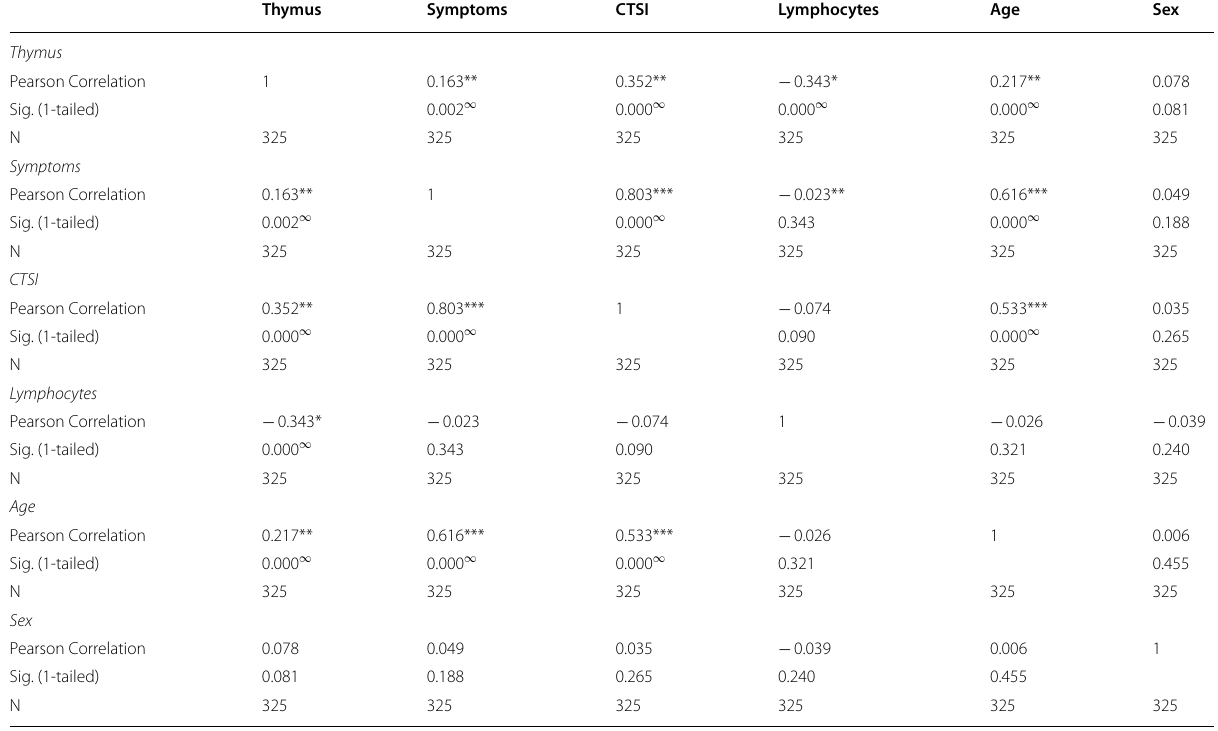
Table 2 Multivariate SPSS analysis including Pearson correlation and linear regression significant analyses